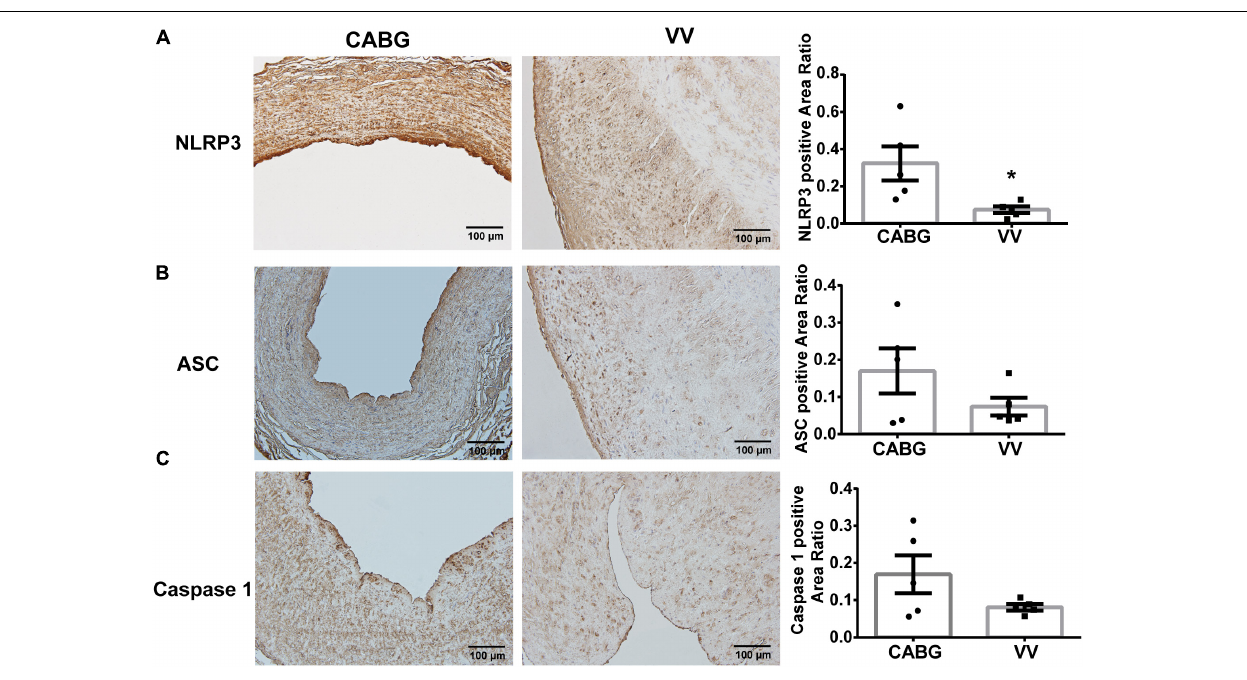
FIGURE 4 | The immunohistochemistry staining showed that the expression of NLRP3, ASC and Caspase 1 were decreased in varicose veins. (A) Representative photomicrographs of immunohistochemistry staining for NLRP3. Box plot showed that the expression of NLRP3 significantly decreased in varicose veins. (B) Representative photomicrographs of immunohistochemistry staining for ASC. Box plot showed that the expression of ASC has a trend to decrease in varicose veins. (C) Representative photomicrographs of immunohistochemistry staining for Caspase 1. Results show a trend to decrease in varicose veins. ∗ P <